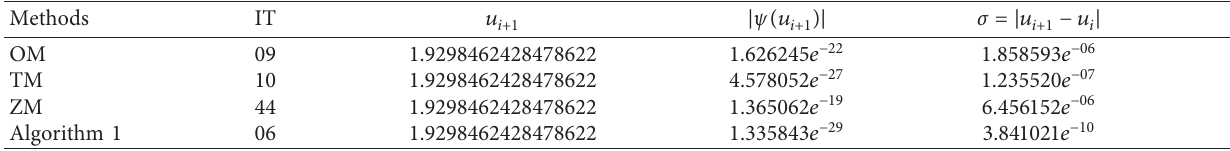
Table 3: Comparison among different fourth-order algorithms.